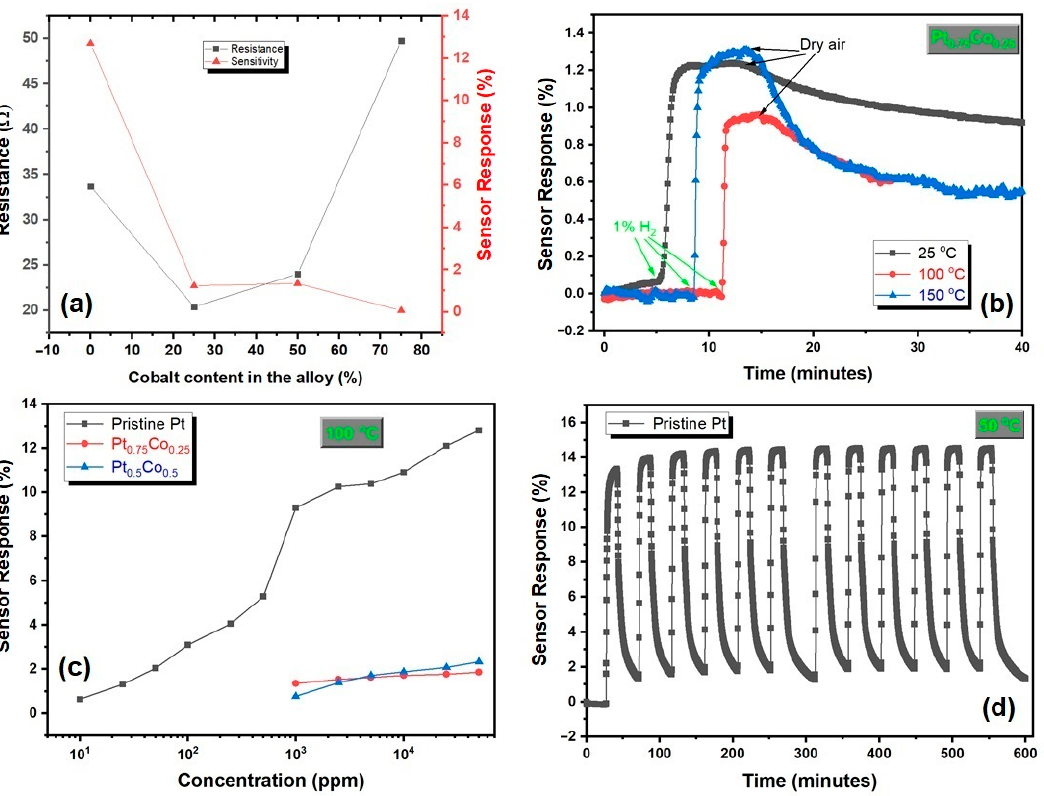
Figure 5. ( a ) Resistance and sensor response of the films exposed to 1% hydrogen as a function of Co content at room temperature, ( b ) sensor response versus time for Pt 0.75 Co 0.25 alloy thin film at 25 °C, 100 °C, and 150 °C exposed to 1% hydrogen, ( c ) sensor response as a function of logarithmic concentration for pristine Pt, Pt 0.75 Co 0.25 , and Pt 0.75 Co 0.25 alloy thin films at 100 °C and ( d ) stability cycles of pristine Pt at 50 °C.